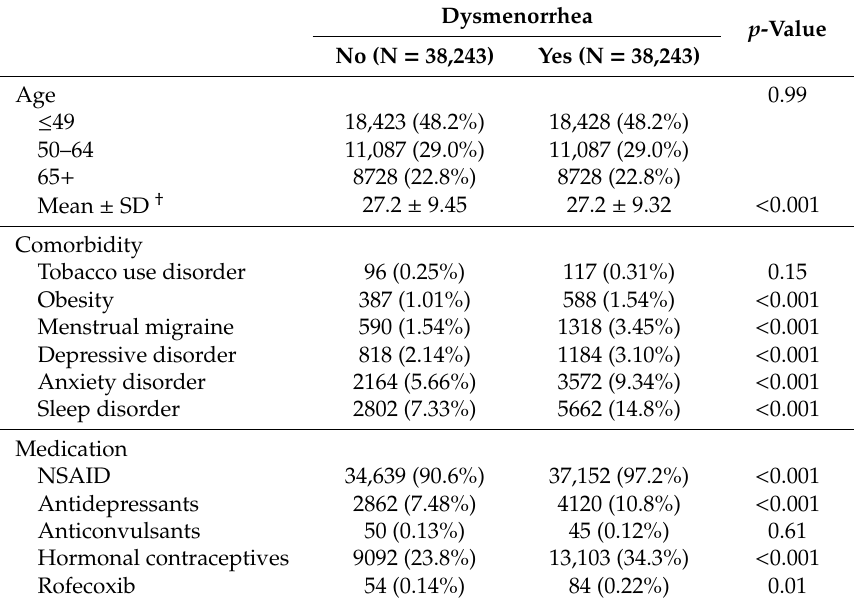
Table 1. Demographic characteristics and comorbidities in cohorts with and without dysmenorrhea.